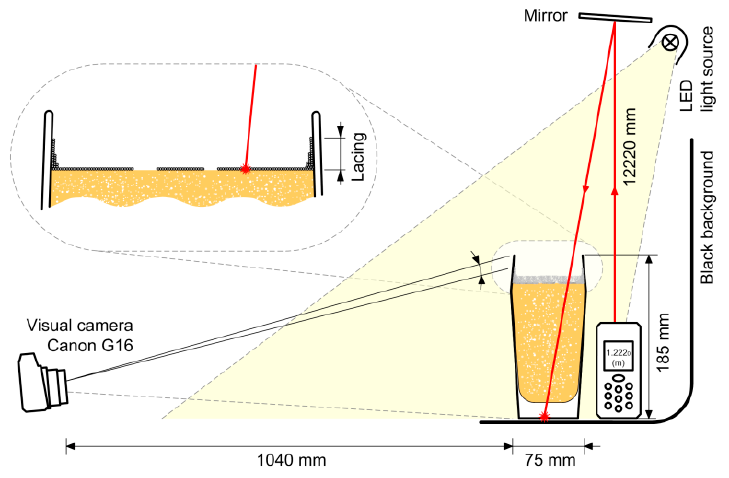
Figure 3. Experimental setup.